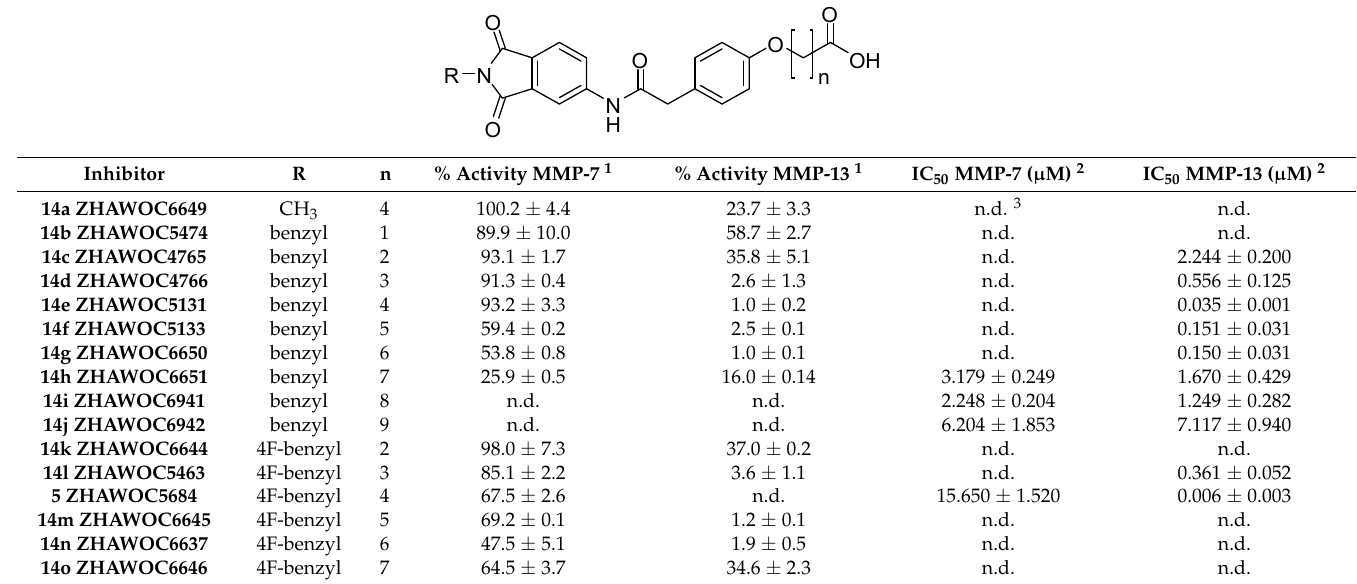
Table 2. Inhibitory data for MMP-7 and